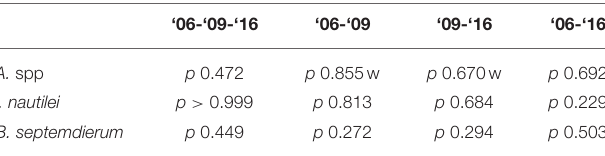
TABLE 3 | The statistical results for repeated measures of chemoautotrophic bacteria-containing invertebrate coverage on the edifices ( n = 5): Friedman tests for all years combined and three sets of paired tests (paired t -test by default or “w” for Wilcoxon signed-rank